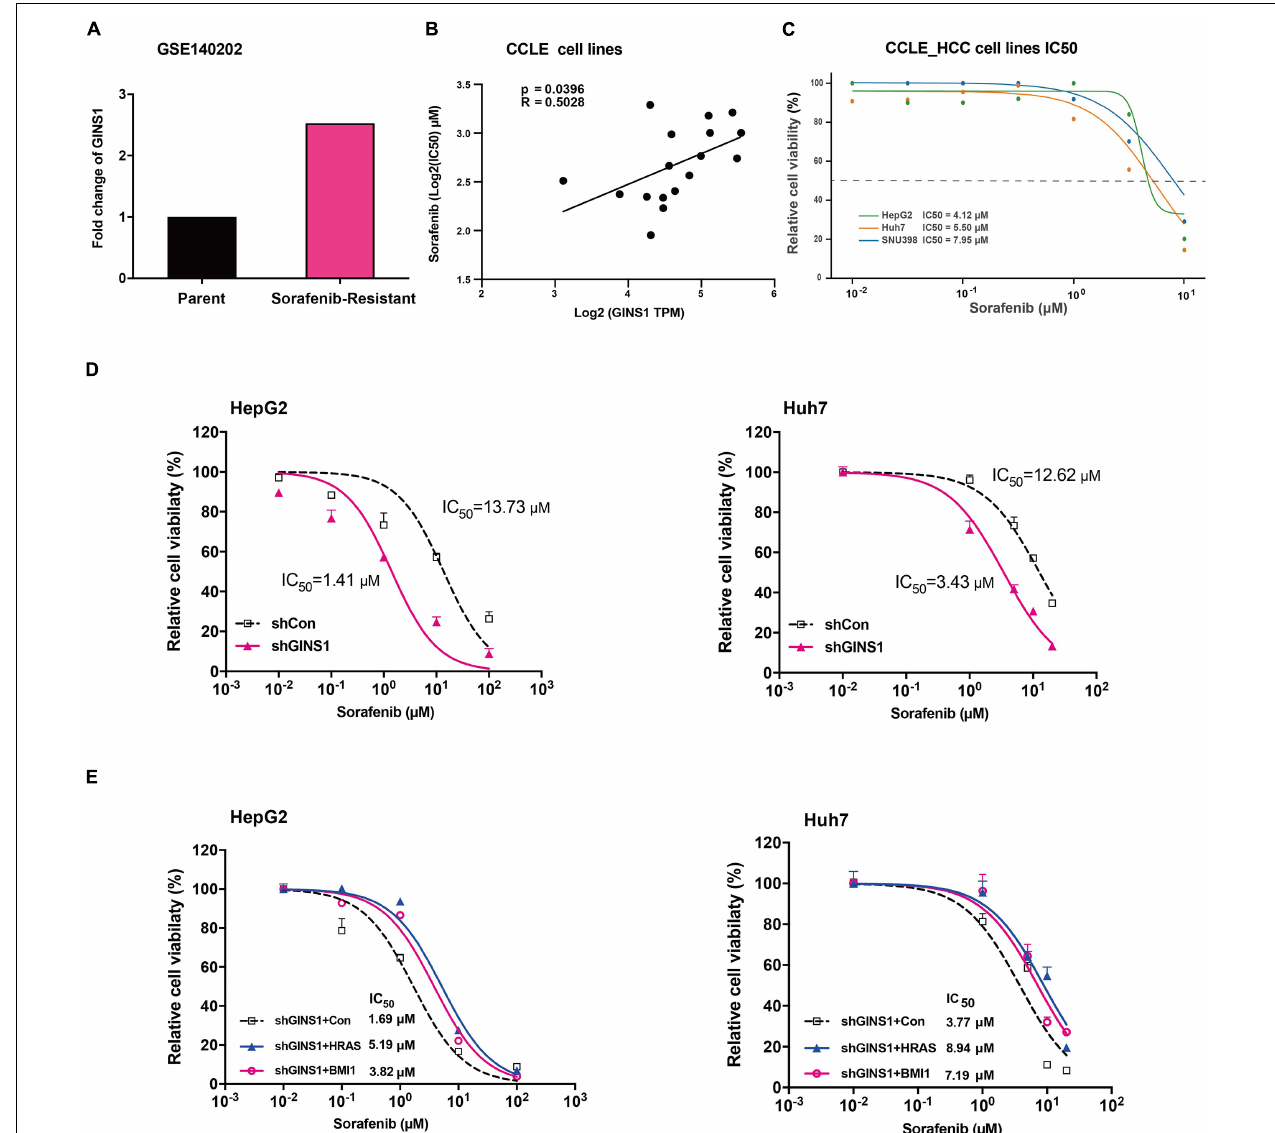
FIGURE 5 | Sorafenib resistance regulated by GINS1 in HCC cells. (A) gene expression of GINS1 in HepG2 sorafenib-resistance and parent cell lines from GSE140202 (GEO database). (B,C) correlation of sorafenib IC50 and GINS1 expression in 17 hepatocellular carcinoma and colon cancer cell lines obtained from CCLE database (B) , and the IC50 value of HCC cell lines (C) . (D) HepG2 (left panel) and Huh7 (right panel) cells, w/o GINS1 knockdown, were treated with different doses of sorafenib as indicted and the cell viability was assessed by the MTT assay. (E) HepG2 shGINS1 and Huh7 shGINS1 cells, rescued with HRAS or BMI1 overexpression, treated with different doses of sorafenib as indicted and the cell viability was assessed by the MTT assay. Data are presented as mean ±